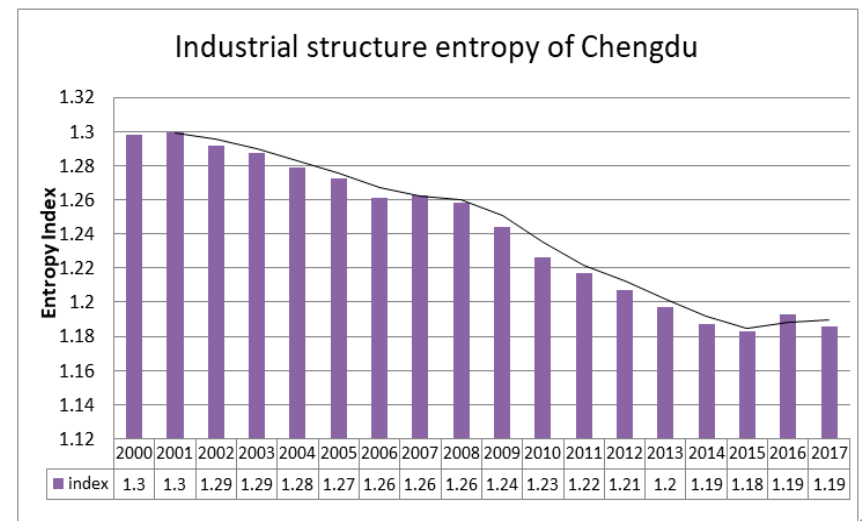
Figure 5. ISE in Chengdu from 2000 to 2017 and the two-period moving average curve reflects the trend of ISE.